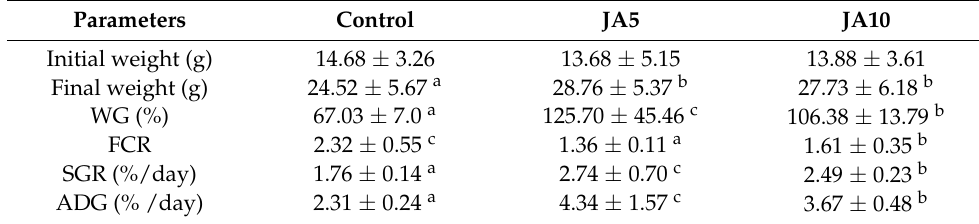
Table 2. Growth performance and feed utilization of red tilapia fed experimental diets for 4 weeks. Parameters